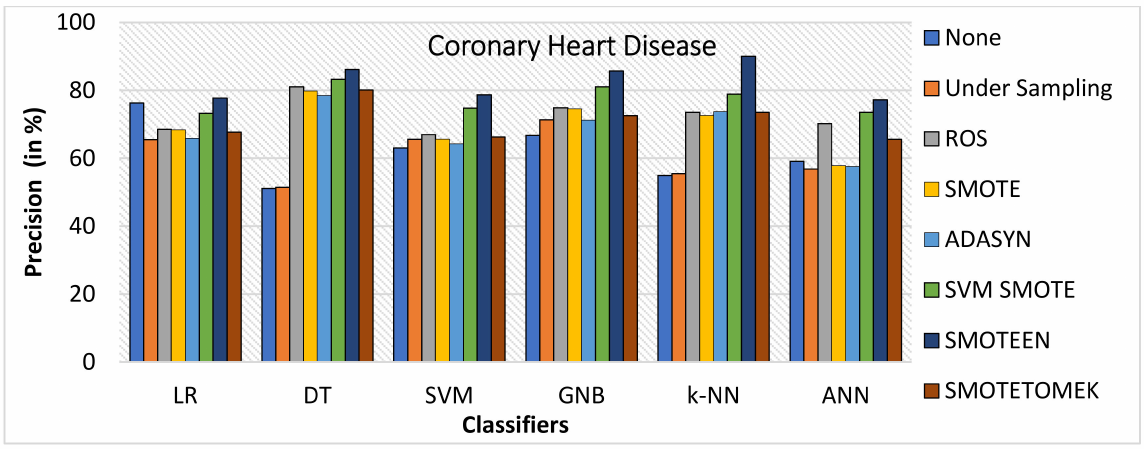
Figure 19. Precision for coronary heart disease dataset of balancing algorithms over six classifiers.